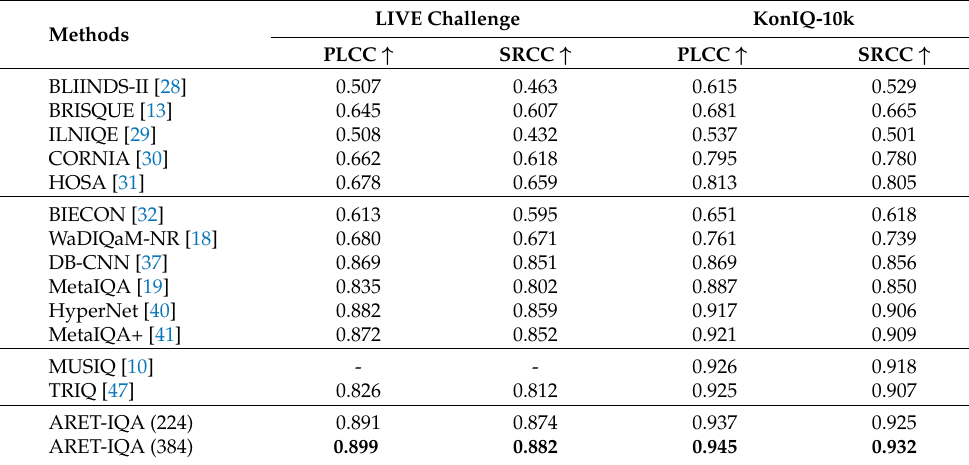
Table 1. Comparison results (PLCC and SRCC) of the proposed method with several state-of-the- art IQA methods on the LIVE challenge [46] and KonIQ-10k [27] databases, where “-” indicates unreported results. In our ARET-IQA model, the input images were resized to two default resolutions for the Transformer network: 224 × 224 (ARET-IQA (224)) and 384 × 384 (ARET-IQA